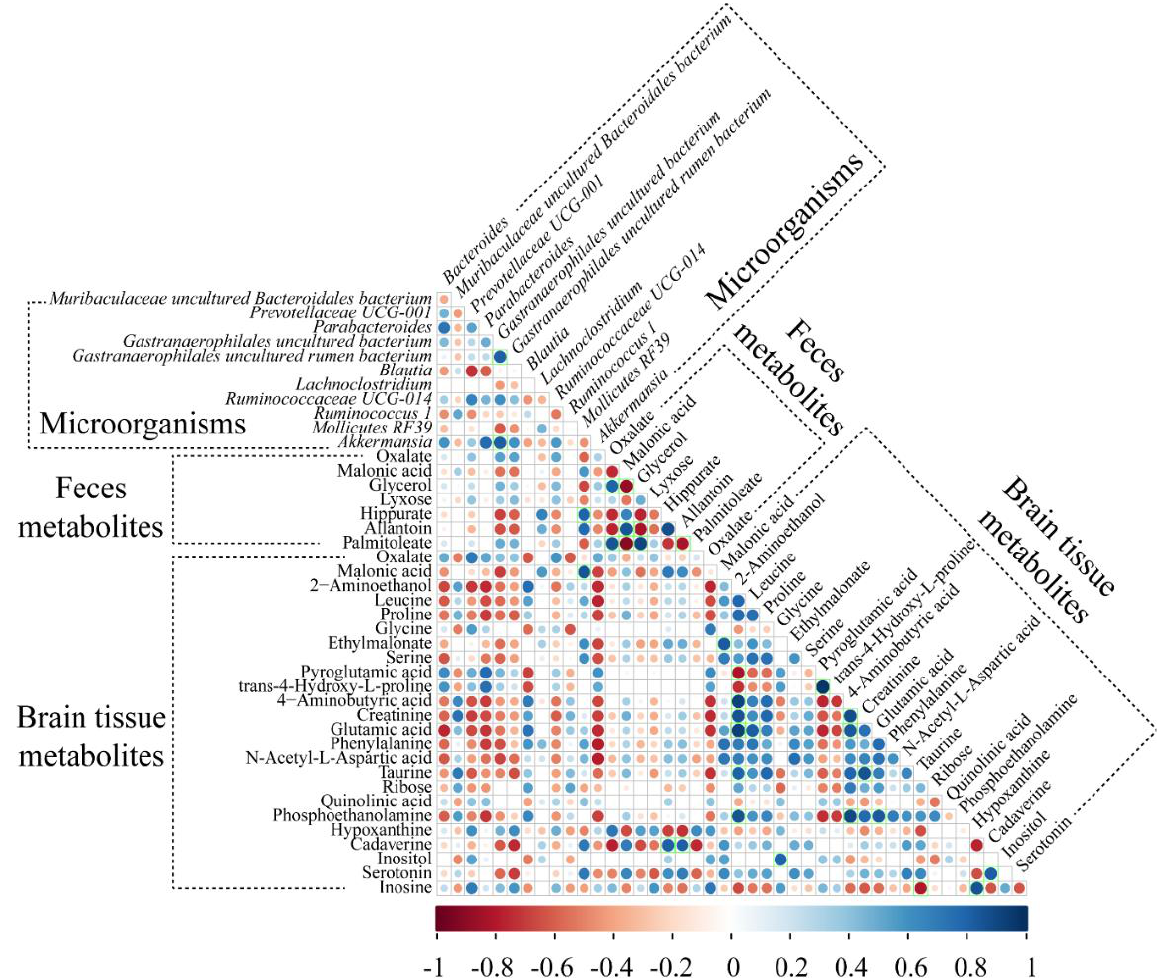
Figure 6. Heat map shows correlations ( Spearman’s rank correlation, p < 0.05) among the identified brain tissue metabolites, feces metabolites, and feces microbiota. R-values of 0.8 or more are highlighted with green borders.